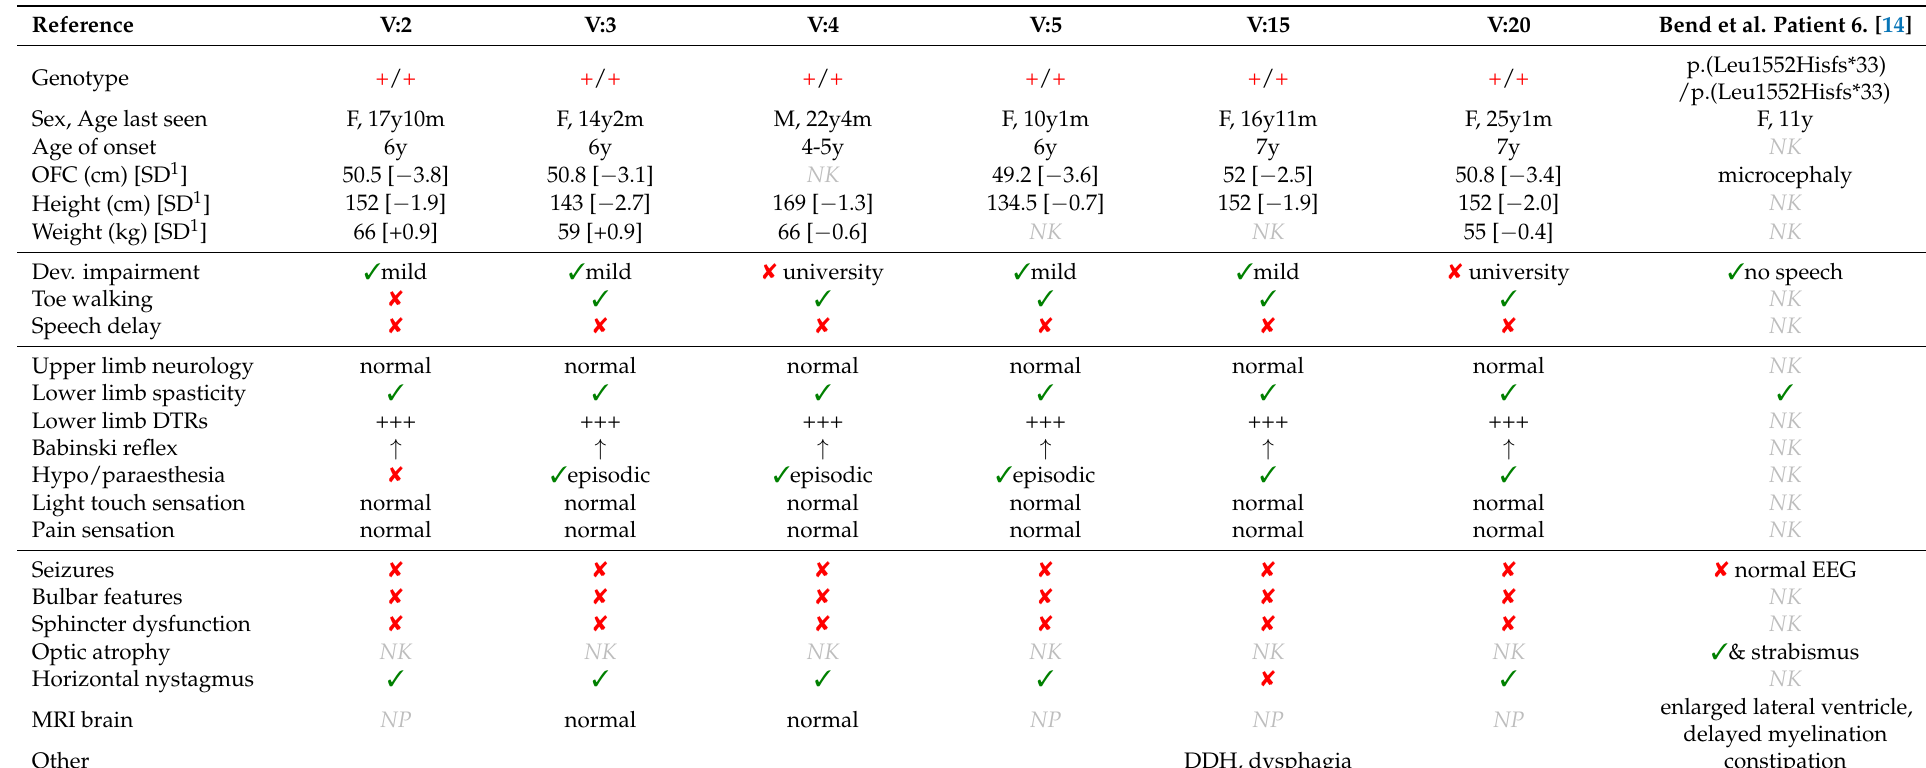
Table 1. A comparison of clinical findings of affected individuals homozygous for final exon frameshift PTPN23 gene